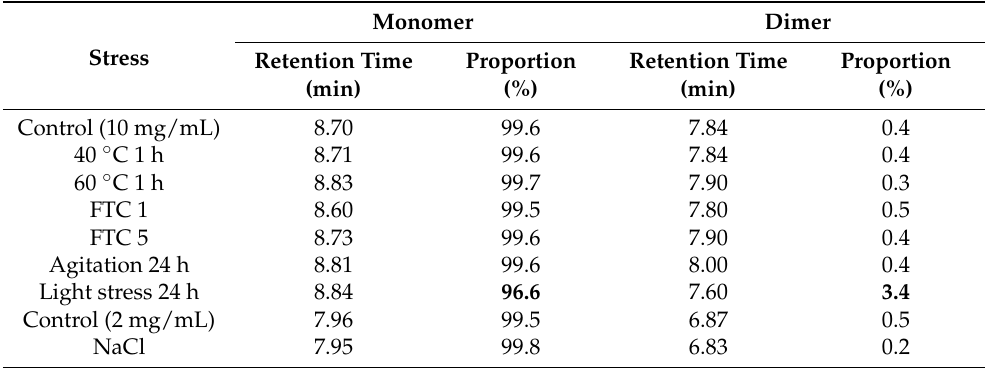
Table 6. Overall results for experimental retention time and relative proportions in the SEC analysis. Results that are significantly different from the control appear in bold type.